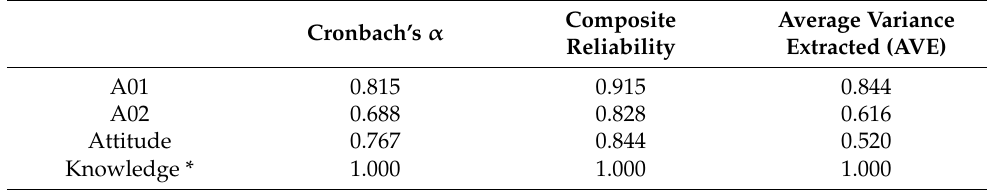
Table 4. The construct validity and reliability of the OKABQ.